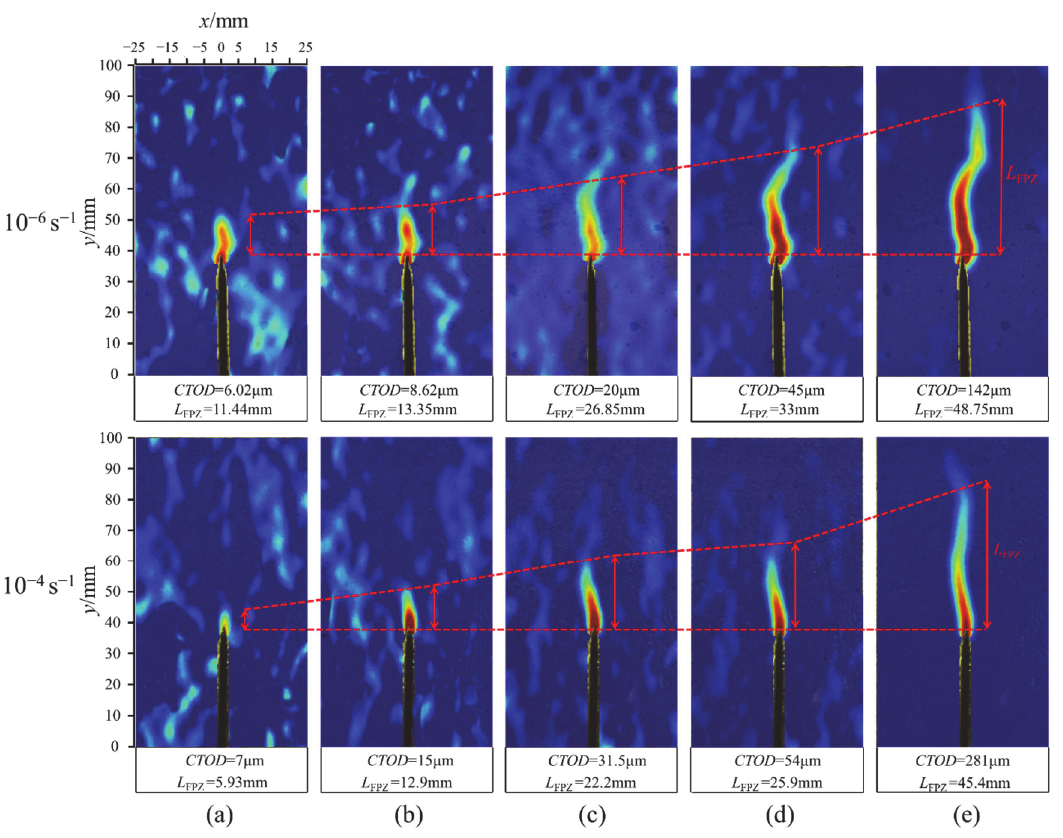
Figure 14. The strain contours of 0.6% BFAPC at strain rate of 10 − 6 s − 1 and 10 − 4 s − 1 : ( a ) Pre ‐ 60% P max ; ( b ) pre ‐ 80% P max ; ( c ) P max ; ( d ) post ‐ 80% P max ; and ( e ) post ‐ 20% P max .